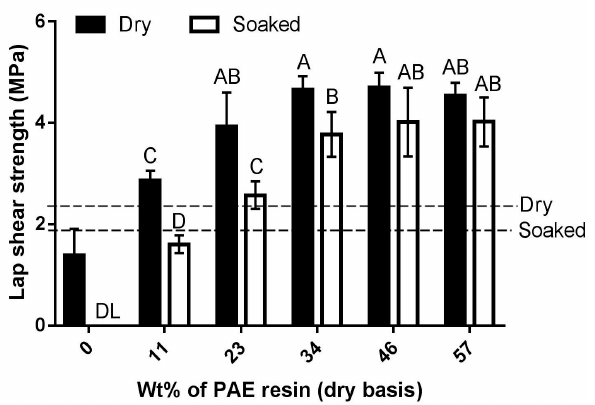
Figure 3. Effect of the weight ratio of peptides and PAE on lap shear strength of plywood specimens bonded with the peptides–PAE adhesive. Specimens were crosslinked for 120 min, and then hot pressed at 120 °C and 3.5 MPa for five min. Error bars are standard deviation of six plywood specimen measurements. Specimens that delaminated when soaked in water are indicated (DL). Means that do not share a letter are significantly different (Tukey, 95% confidence level). The minimum shear strength requirements as specified by ASTM D4690 are shown: 2.344 MPa for dry shear strength; 1.93 MPa for soaked shear strength [34].